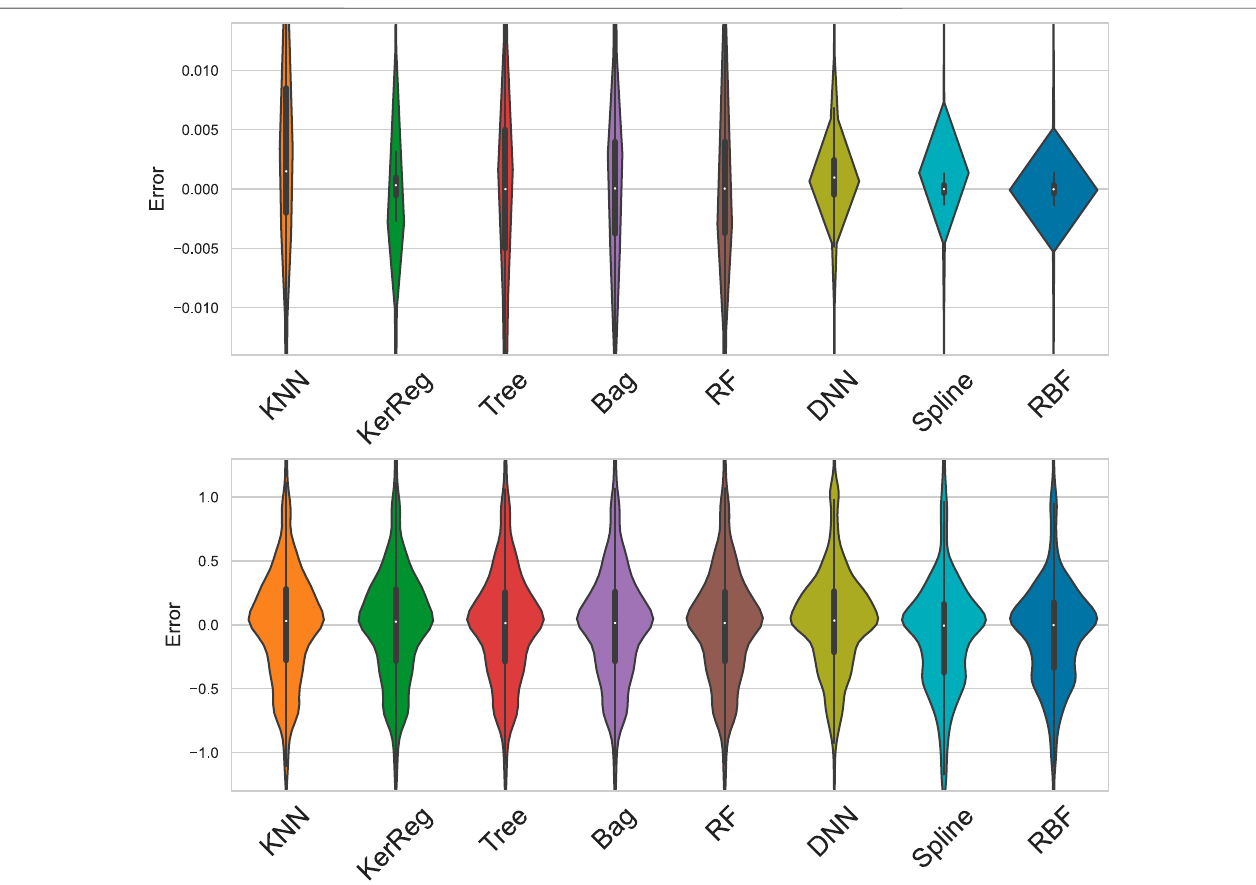
FIGURE 1 | Violinplots of error e i (cid:2) y i − ^ y i evaluated on (top) TEST_M13 and (bottom) TEST_M13_L of all the methods, trained on TRAIN_M13. For each ML- method, the outside envelop is the smoothed distribution of error, symmetric for visualization consideration, with a box-whiskers plot inside (median with a white circle, 1st and 3rd quartiles are represented by the border of the